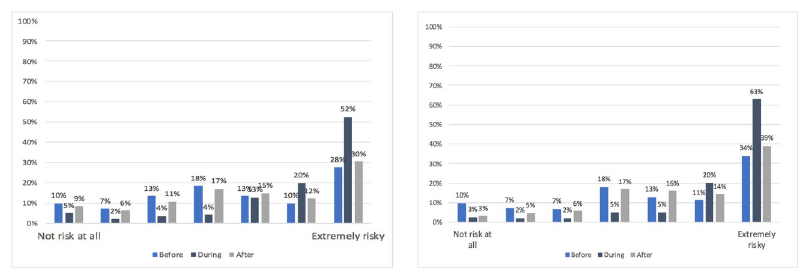
Fig 1. Distribution of risk perception evaluation over time, comparing responses of males (left) and females (right) to the question: ‘How much do you perceive the risk of being infected with COVID-19 while traveling with public